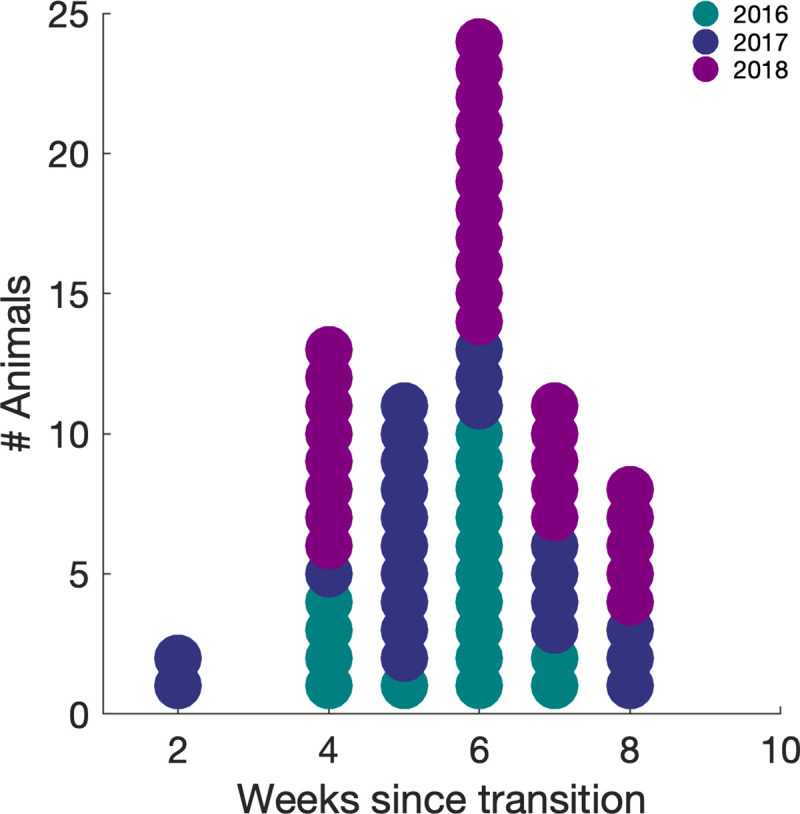
Timing of oestrus relative to daylight change.Dot histogram with each dot representing the timing of oestrus in a single animal colour coded by the year in which the measurement was made 2016, 2017 and 2018.